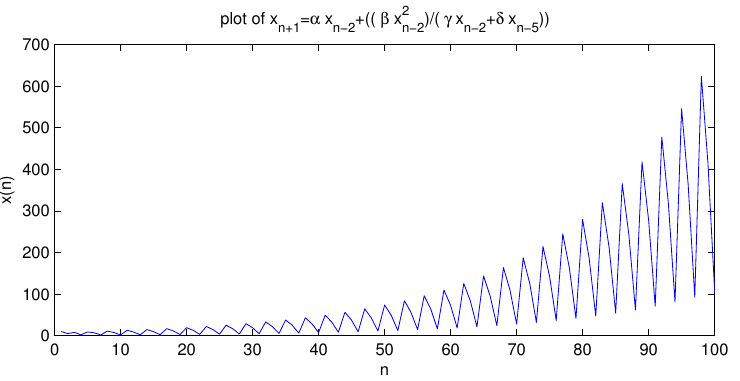
Figure 1. Expresses the solution of x n + 1 = α x n − 2 + constants x − 5 = 10, x − 4 = 5, x − 3 = 8, x − 2 = 2, x − 1 = 9, x 0 = 7, α = 0.5, β = 6, γ = 9, δ = 10.